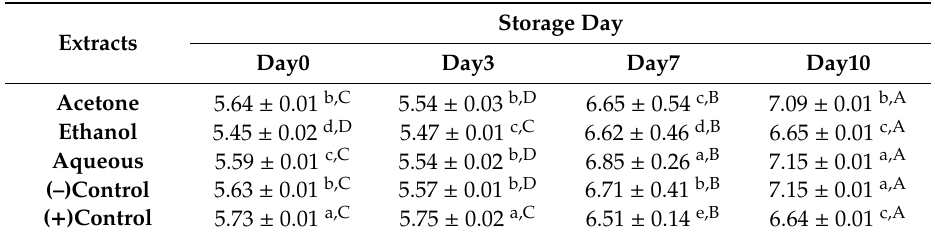
Table 3. Average pH value (pH) in beef burgers added Oudneya africana leaves extracts (with 0.03%) stored at 4 ◦ C during 10 days under simulated retail display